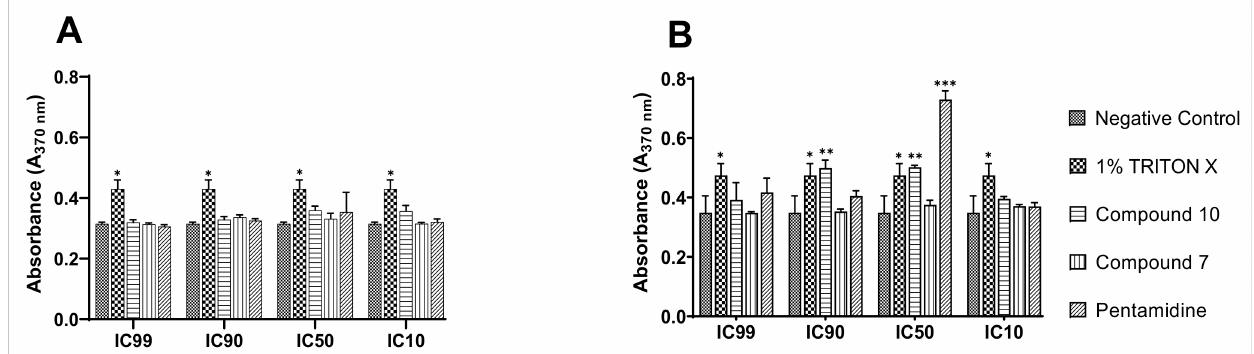
Figure 11. DNA fragmentation and cytolysis induced by compound 10 in bloodstream forms of Trypanosoma brucei brucei . BrdU-labeled parasites at 4 × 10 5 cells/mL were incubated in the presence or absence of compounds 7 and 10 at their IC 99 , IC 90 , IC 50 , and IC 10 for 4 h in growth conditions, and the culture supernatant (( A ), cytolysis) and lysate ( B ) were further processed using the Cellular DNA Fragmentation Kit. *** Significant difference at p < 0.001; ** Significant difference at p < 0.01, * Significant difference at p < 0.05; ns: Not significant difference; Negative control: untreated parasites; 1% Triton-X was used as a positive